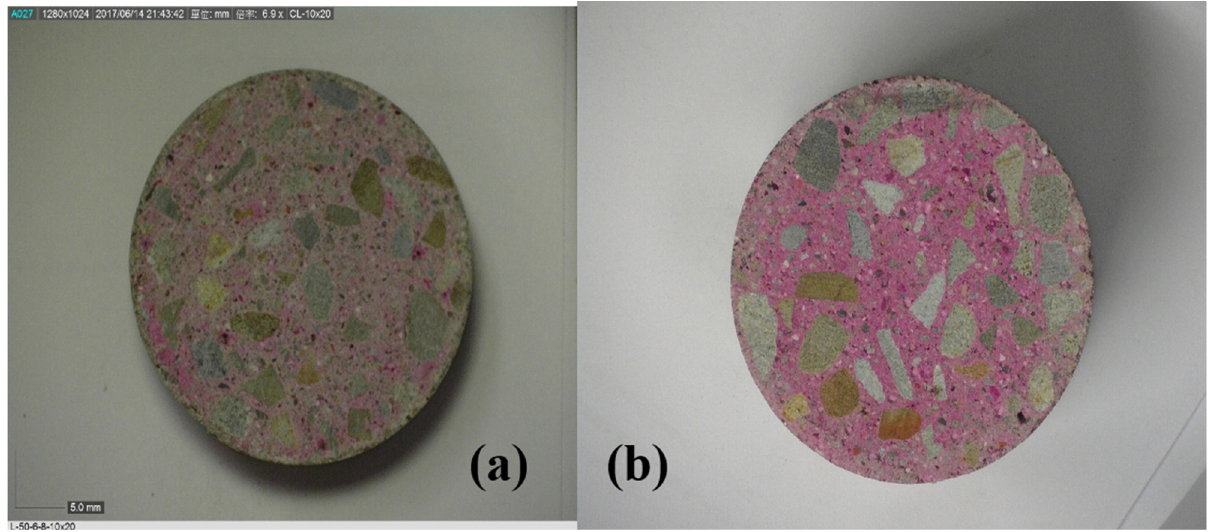
Figure 12. Neutralized degree observation of normal concrete ( a ) CO 2 -cured specimen and ( b ) water-cured specimen at 90-days. Table 9. Neutralization results of 10 × 20 cm cylindrical specimen.